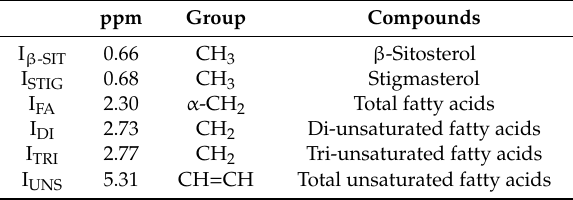
Table 2. Compounds and relative signals (ppm) selected for quantitative analysis in the organic